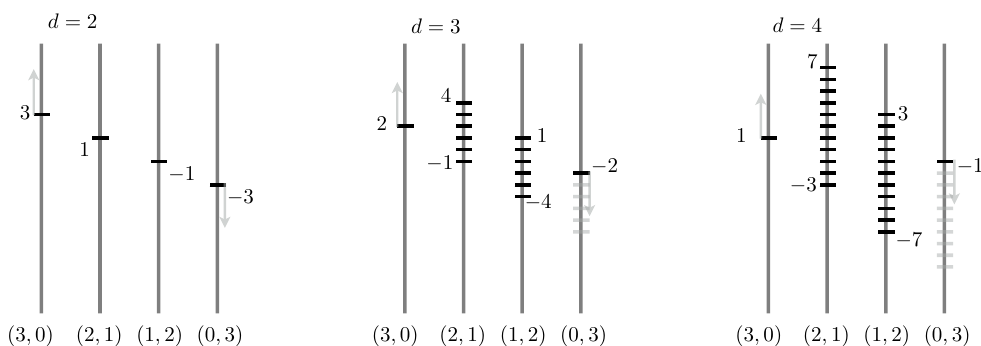
Figure 1 . The range of twisted cohomologies for the Fermat quadric, cubic, quartic ( d = 2 ; 3 ; 4 respectively). In degrees (2 ; 1) and (1 ; 2), a tick denotes a degree for which twisted cohomology is non-vanishing; the actual dimensions are equal to the ones for H 1 ( M 6 ; T ( k )) in table 1. In degree (3 ; 0), cohomology is non-zero for k the black tick; in (0 ; 3), for k the black (cid:21) (cid:20)